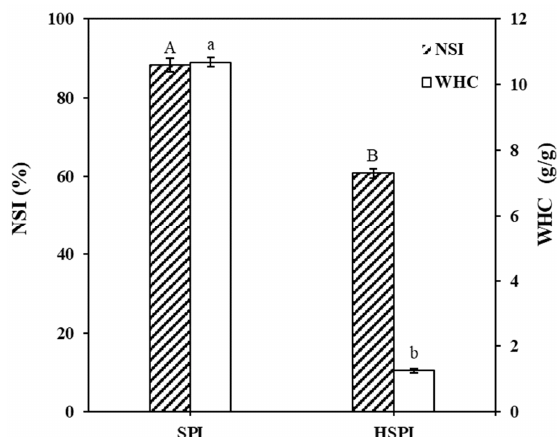
Figure 1. Nitrogen soluble index (NSI) and water holding capacity (WHC) of SPI (soy protein isolate) and HSPI (hydrolyzed soy protein isolate). Significant differences are indicated by different lowercase letters (A-B, a-b) ( p < 0.05).